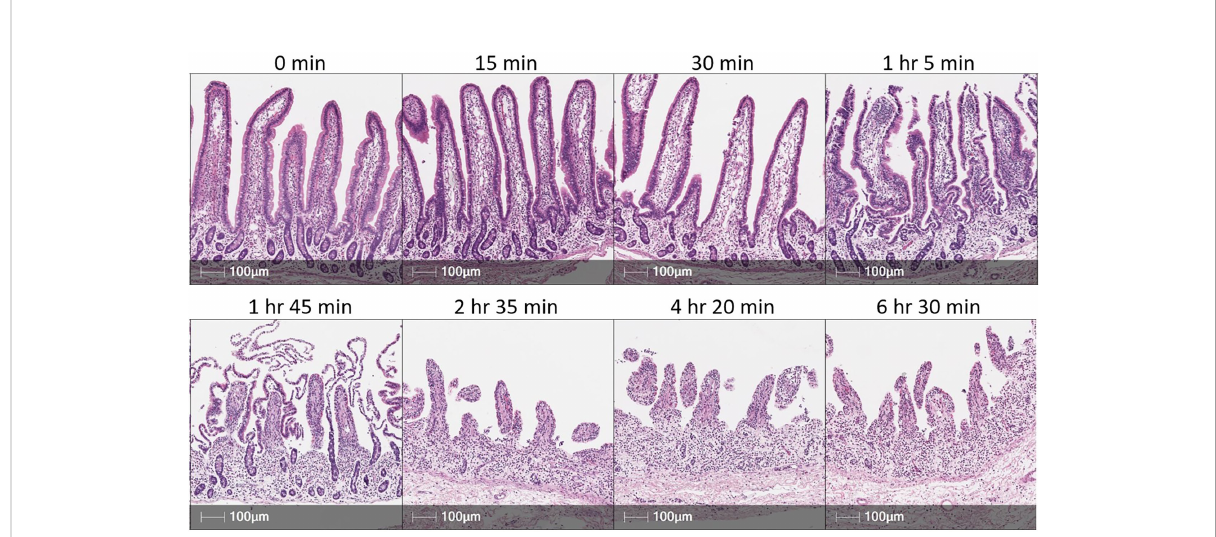
FIGURE 4 EDTA incubation time in fl uences epithelial cell removal in porcine intestinal tissues. H&E sections of porcine small intestinal tissue subjected to incubation in EDTA solution for various amounts of time. Tissue was derived from terminal ileum of a ~3-month-old pig. After dissociating mucus from tissue [described elsewhere (66)], ~2 grams of tissue was placed into 200 mL of epithelial removal solution (5mM EDTA and 2% FCS in HBSS) and incubated at 37°C, 200 rpm for amounts of time speci fi ed above each image panel. Tissues were not transferred into fresh EDTA solution throughout the duration of speci fi ed incubation time. Cell recovery did not substantially increase from 2 hr 35 min to either 4 hr 20 min or 6 hr 30 min incubations. This fi gure is not intended as a reference for an EDTA incubation time for optimal epithelial removal but to emphasize that individual optimization of methods for epithelial cell removal will be necessary based on technical and biological contexts of an experiment. EDTA (ethylenediamine tetraacetic acid); FCS (fetal calf serum); H&E (hematoxylin and eosin); HBSS (Hank ’ s balanced salt solution); hr (hour); min (minute); mL (milliliters); mM (millimolar); rpm (rotations per